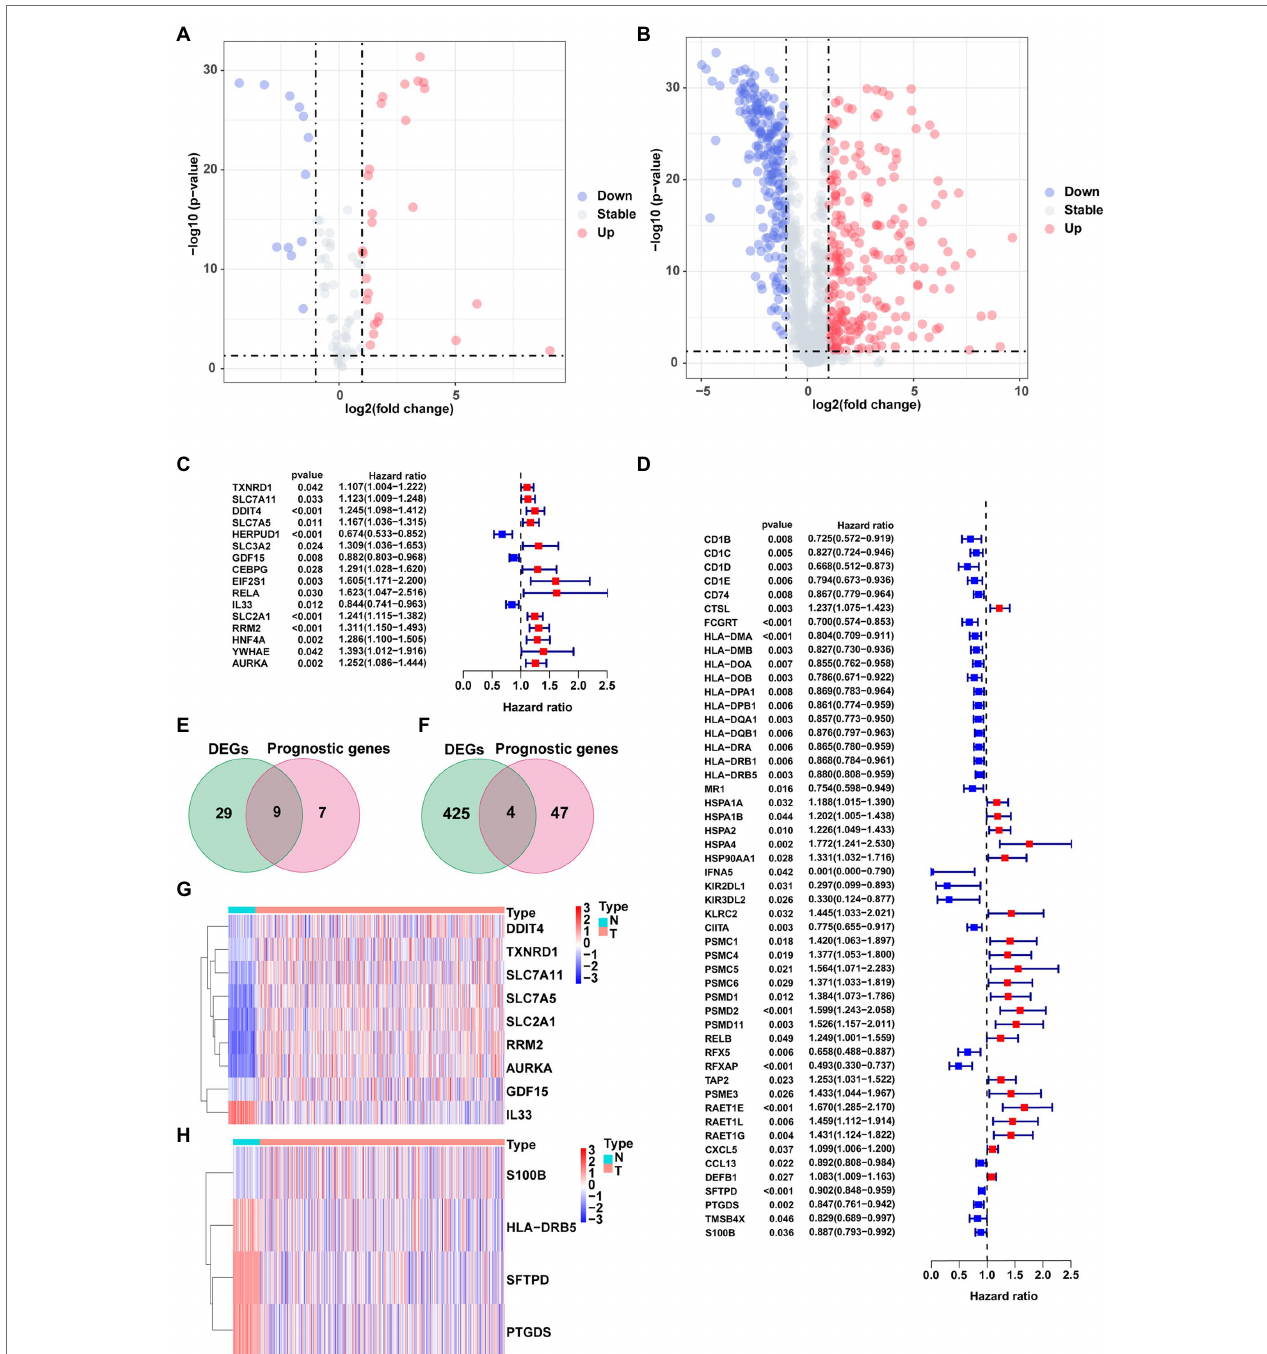
FIGURE 2 | Identification of prognostic ferroptosis-related DEGs and immune-related DEGs. (A) Volcano plot of ferroptosis-related DEGs. (B) Volcano plot of Immune-related DEGs. (C) Forest plot from the univariate Cox proportional hazards regression analysis between FRG expression and survival time. (D) Forest plot from the univariate Cox proportional hazards regression analysis between IRG expression and survival time. (E,F) Venn diagrams of overlapping candidate genes. (G,H) Heatmap plots of overlapping candidate